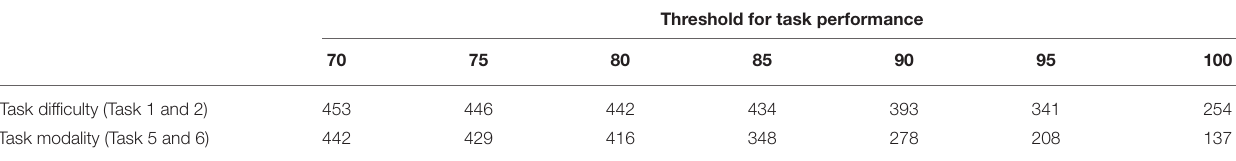
TABLE 3 | Number of samples in each class used for training the algorithms at each threshold value of task